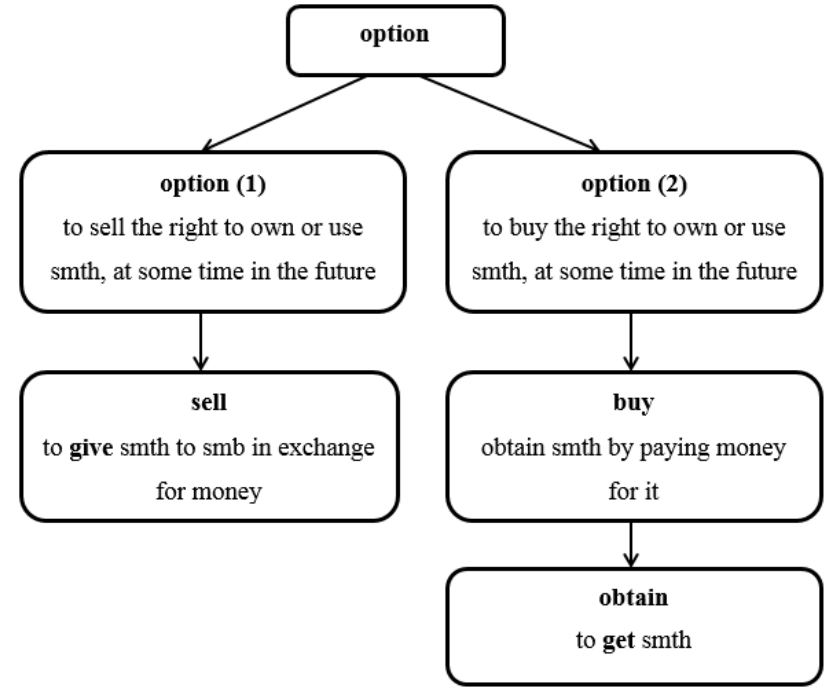
Fig. 2 – Meaning components of the enantionym